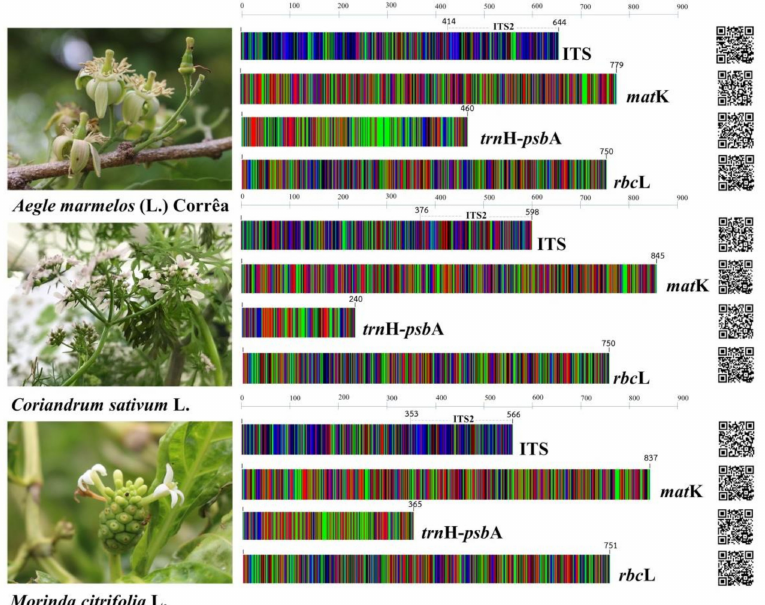
Figure 8. DNA barcoding images of four DNA barcode loci: ITS, mat K, psb A- trn H, and rbc L belonging to Aegle marmelos (L.) Corr ê a, Coriandrum sativum L., and Morinda citrifolia L., respectively. Different colors are representative of different bases: green base A, red base T, blue base C, and black base G. The quick response code (QR code) for accession to nucleotide sequences was submitted to DDBJ/ENA/GenBank genetic